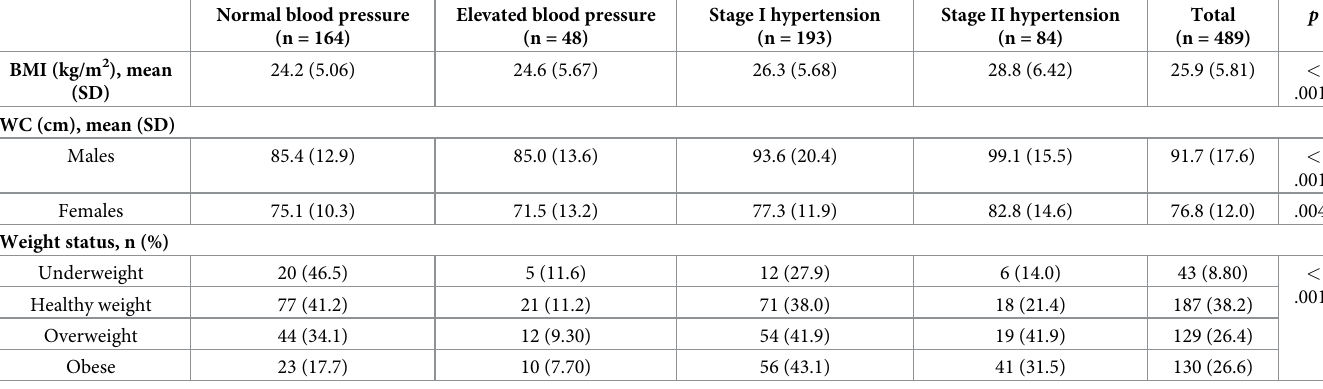
Table 2. Anthropometric measurements of participants stratified by blood pressure status (n =